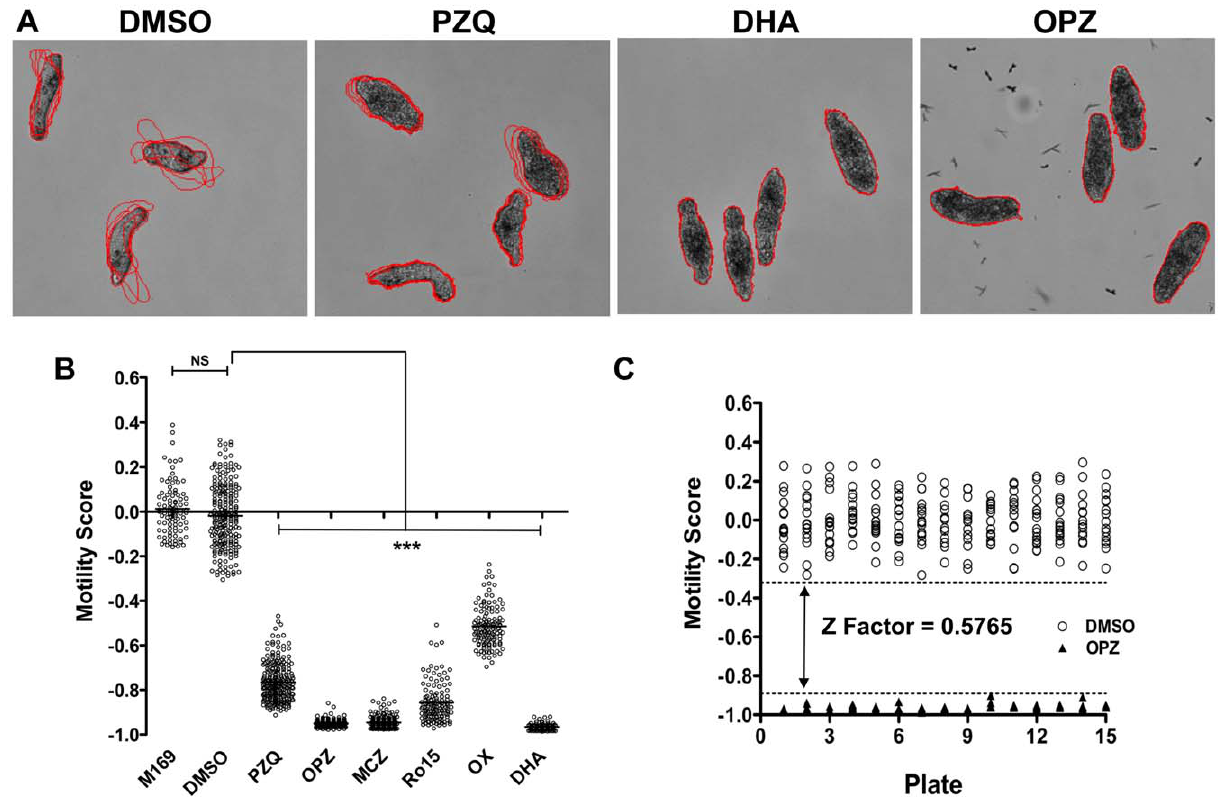
Figure 3. Automated image analysis of larval motility following treatment with anti-schistosome compounds. Original images were firstly segmented as described Figure 1 and then the cumulative change in area for each individual larva measured over 5 time frames. The scores for individual larvae were averaged to generate a motility score per well. ( A ) Illustration of differences in larval motility between a high motility well (DMSO) with low overlap between larval location in successive time frames (red boundaries), a medium motility well (PZQ; praziquantel) and low motility wells with almost perfect overlap between successive time frame boundaries (DHA; dihydroartemisinin & OPZ; oltipraz). ( B ) Representative motility scores from 5 plates of anti-schistosome compounds (10 m g/ml), n=120 wells per condition and significance values were measured by non- parametric one-way ANOVA with individual drug treatments being compared to the DMSO controls wells using a Dunn’s comparison post test, ***=p , 0.001. NS; not significant. ( C ) Z factor analysis based on the distribution of the negative (DMSO; open circle) and positive controls (OPZ; closed triangle) from 15 plates (dotted lines represent upper and lower thresholds).